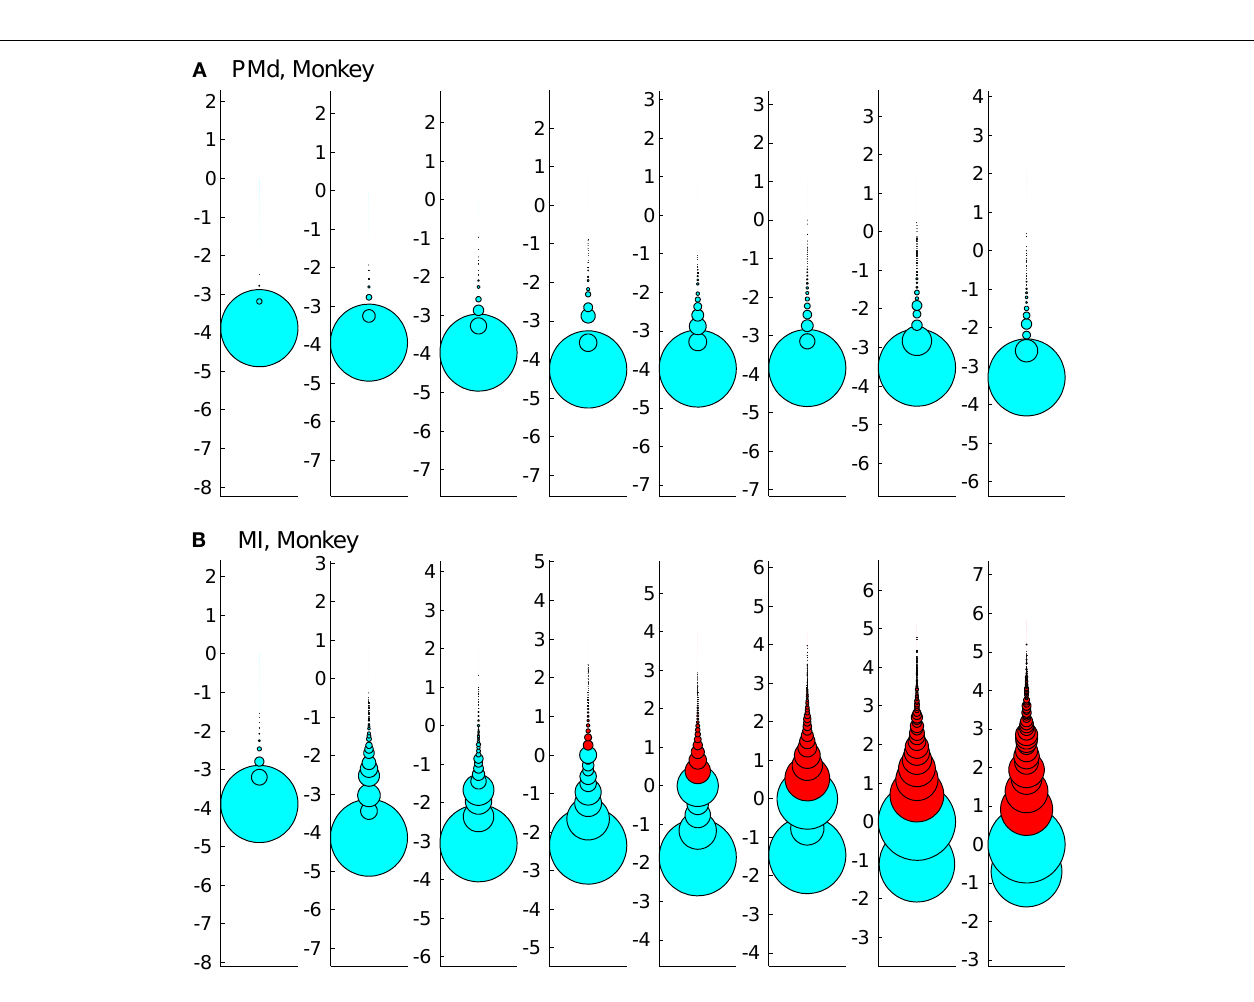
N (number of independent measures; i.e., units in the case of spike avalanches and electrodes in the case of LFP avalanches). Cyan color shows the included avalanches.Y axis is in logarithmic scale for better visualization and the values ofY represent the orders of magnitude of N for proper comparison between different bin sizes (i.e., a given circle at y = 2, represents the avalanches that their size = 2log(N), its diameter shows the number of avalanches that had that size and its color shows whether it is included or excluded according to the X max = N